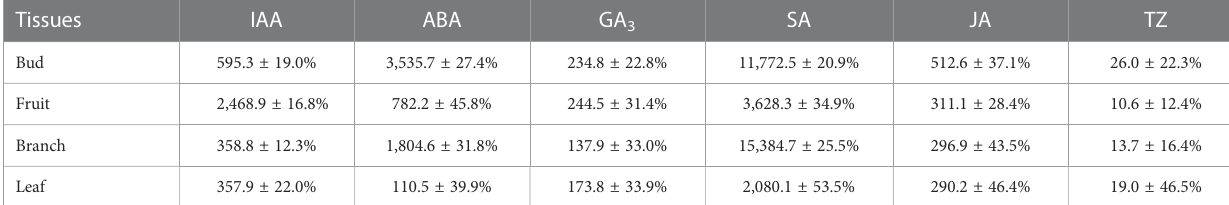
TABLE 1 Endogenous hormone content in different tissues during fl ower bud differentiation of C. oleifera (Mean ± CV, ng/g).